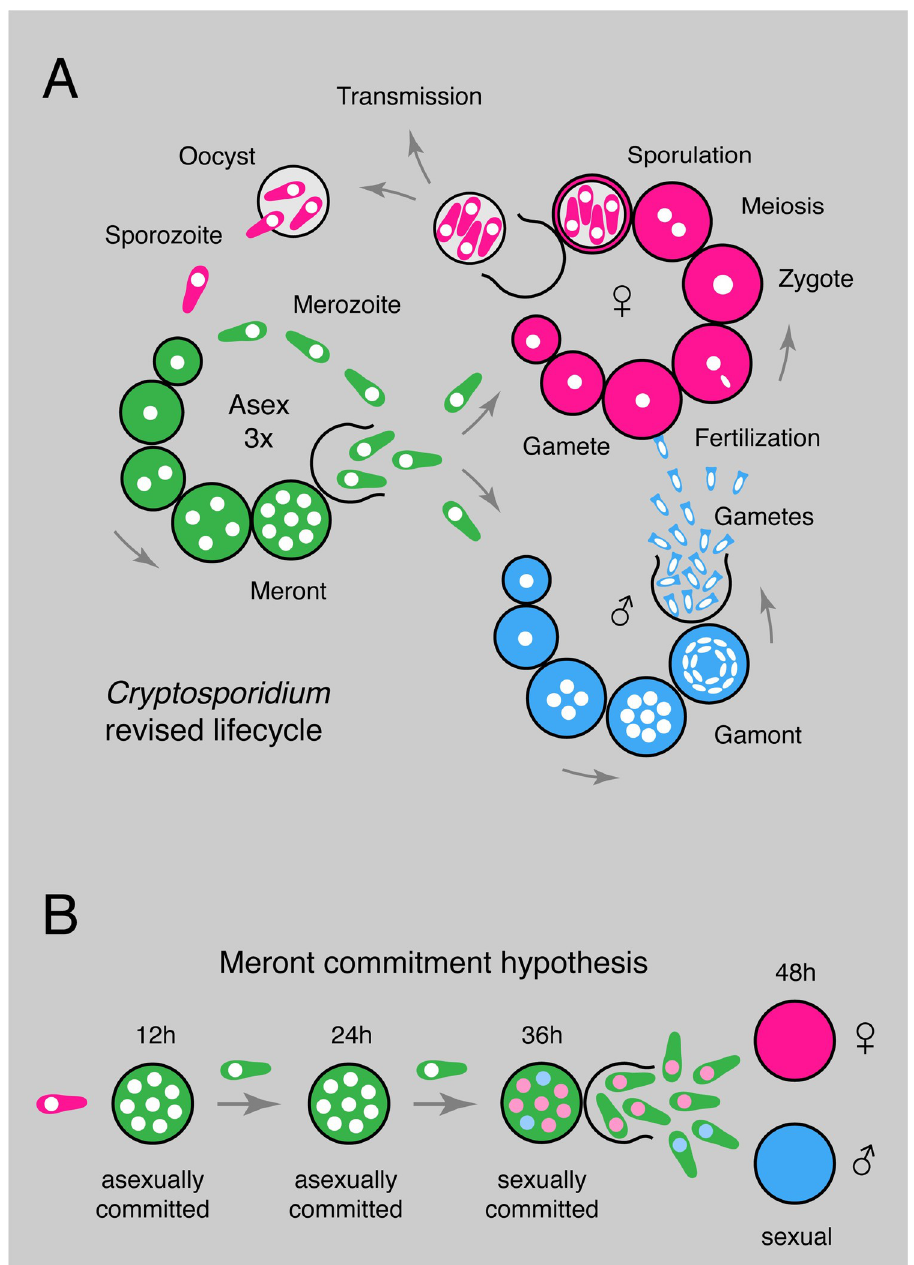
Fig 6. Model of Cryptosporidium life cycle and sexual commitment. (A) Schematic representation of the life cycle for Cryptosporidium summarizing the findings of this study. Infection begins with the oocyst that releases 4 sporozoites that invade intestinal epithelial cells. The parasites replicate asexually (green) by synchronous schizogony for 3 cycles and invariantly produce 8 merozoites. Merozoites emerging from the third round upon reinvasion give rise to sexual stages, both males (blue) and female (pink). The male gamont undergoes 4 rounds of synchronous nuclear division producing 16 gametes, while the female gamete is cell cycle arrested and remains haploid while expanding in size and stockpiling proteins, lipids, and carbohydrates for the future oocyst. Male gametes egress and fertilize intracellular female gametes. Following fertilization, meiosis and sporulation oocysts are released from the host cell and are immediately infectious. Oocysts can be shed with the feces resulting in transmission or excyst and reinfect the same host. (B) We propose a developmental commitment model of life cycle progression for Cryptosporidium . Merozoites emerging a merogony cycle are collectively committed to an asexual or sexual fate and, when sexually committed, give rise to both male and females (commitment is represented symbolically here by coloring the nuclei forestalling future fate; however, we note that the mechanism is unknown and may be independent of the